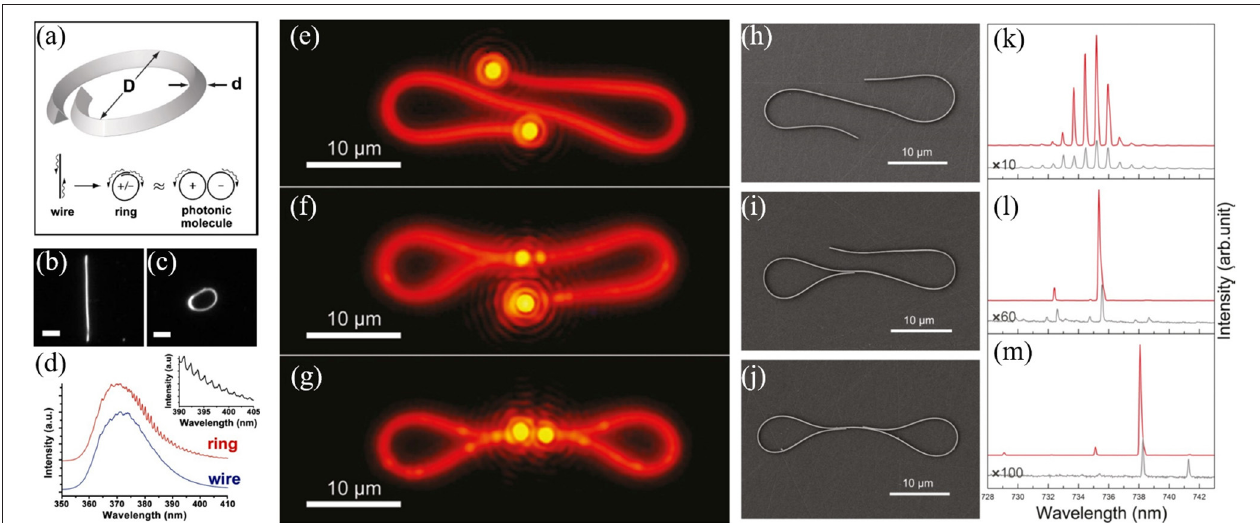
FIGURE 13 | (a) Schematic of the ring cavity based on GaN nanowire. The GaN nanowire before (b) and after (c) physical manipulation. Scale bar: 5 µ m. (d) PL spectra of the nanowire and ring. Inset shows the high-resolution spectrum of the ring. PL microscope images of lasing cavities of single-nanowire structures (e) without loop mirror, (f) with one loop mirror, and (g) with double loop mirrors. (h–j) are their corresponding SEM images. Scale bar: 10 µ m. (k–m) are their corresponding lasing spectra. (a–d) Reproduced with permission. Pauzauskie et al. (2006) Copyright 2006, The American Physical Society. (e–m) Reproduced